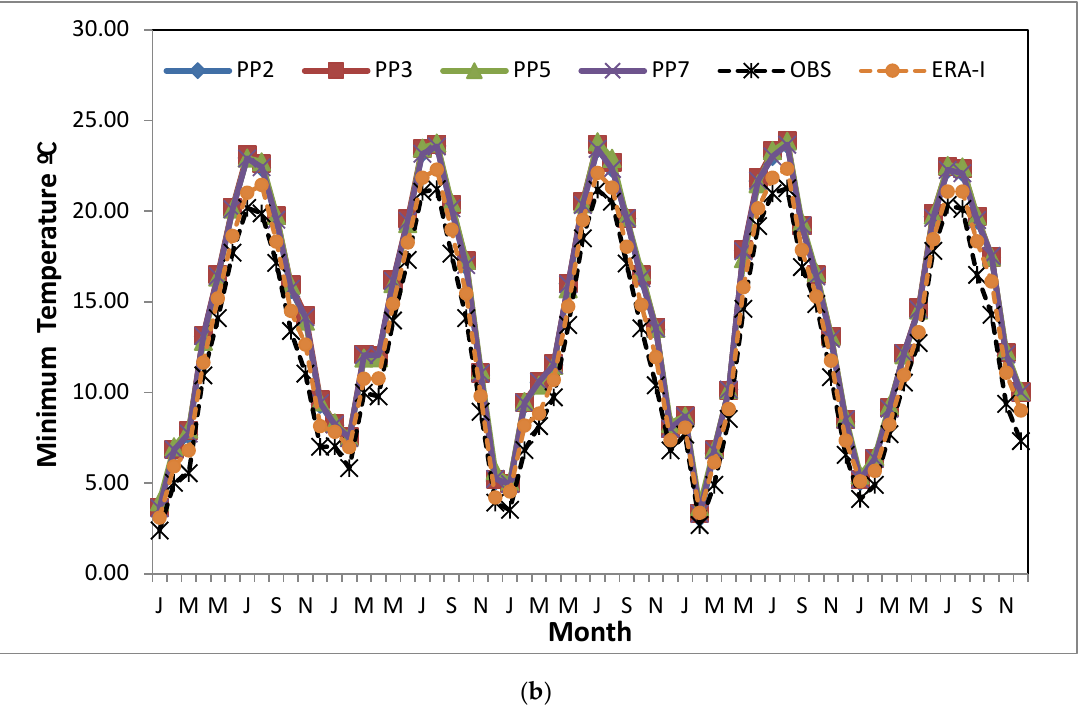
Figure 6. Observed and simulated mean daily TX ( a ) and TN values ( b ), on the total grid stations’ points by month, for the four different simulations (PP2, PP3, PP5, PP7), for the high-resolution domain of Greece (D02) during 2000–2004. Table 6. Statistical metrics of the four simulations in the total grid points for daily minimum temperature (TN), daily maximum temperature (TX) for 2000–2004, over the area of